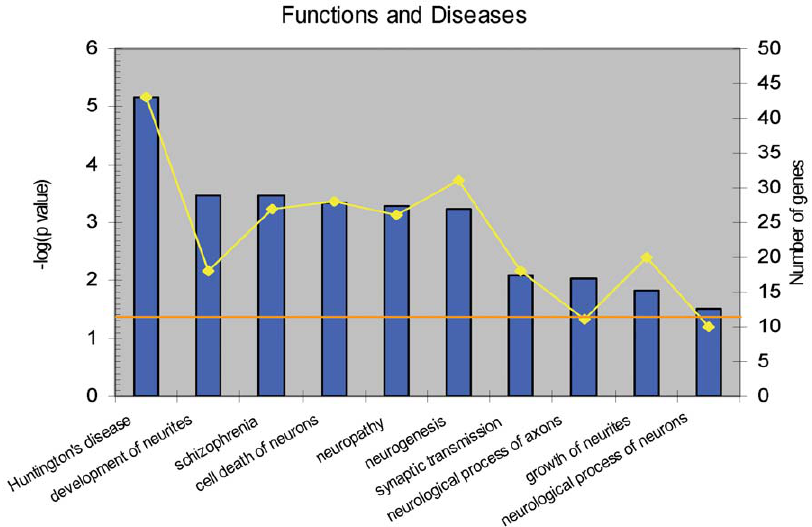
Figure 5. Functional categories perturbed in the SNL L4 DRGs. Functional processes related to Nervous System Development and Function with a minimum of 10 genes are indicated. The bars represent the negative (log p -value) and the orange data points indicate the number of genes for the given functional category. P-values indicate the probability that the observed association between the described functional categories and the SNL pain gene set is due to chance. The ratio indicates the percentage of genes in these functional categories that are found in the SNL pain gene set. The ratio thus indicates the strength of the association, and the p -value measures the statistical significance. The horizontal line indicates a p -value of 0.05.